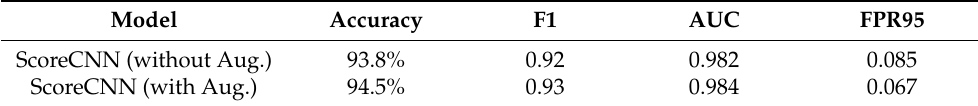
Table 6. Effects of the augmentation on ScoreCNN.